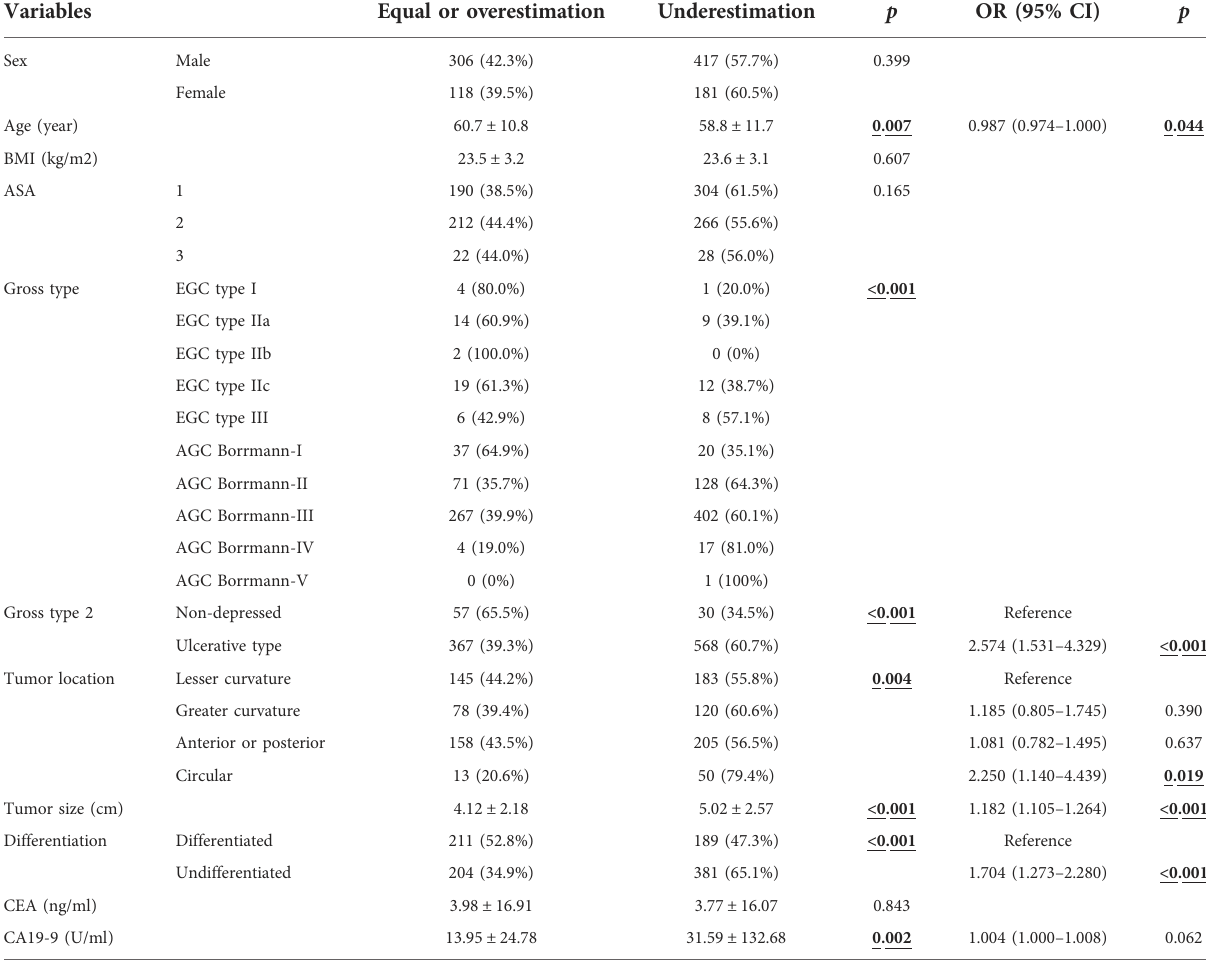
TABLE 2 Univariate and multivariate risk factor evaluation for underestimation for T stage.